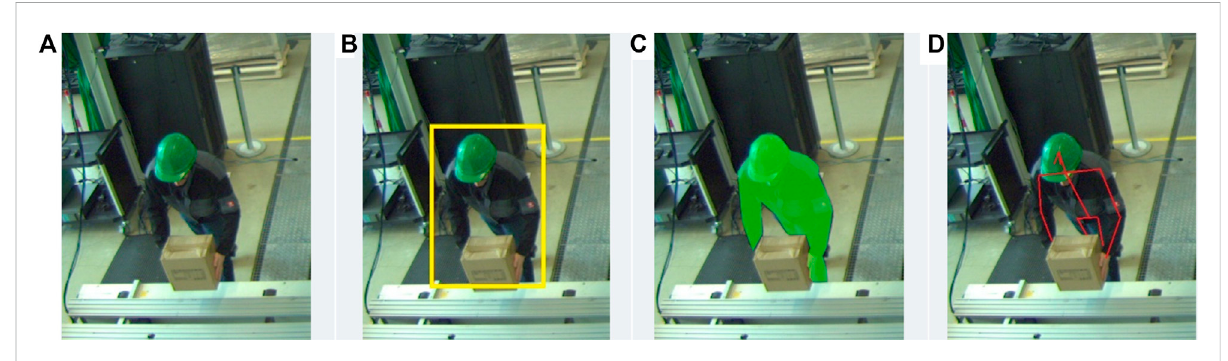
FIGURE 3 Various computer vision tasks for humans detection: classi fi cation (A) , detection (B) , segmentation (C) , skeleton (D)